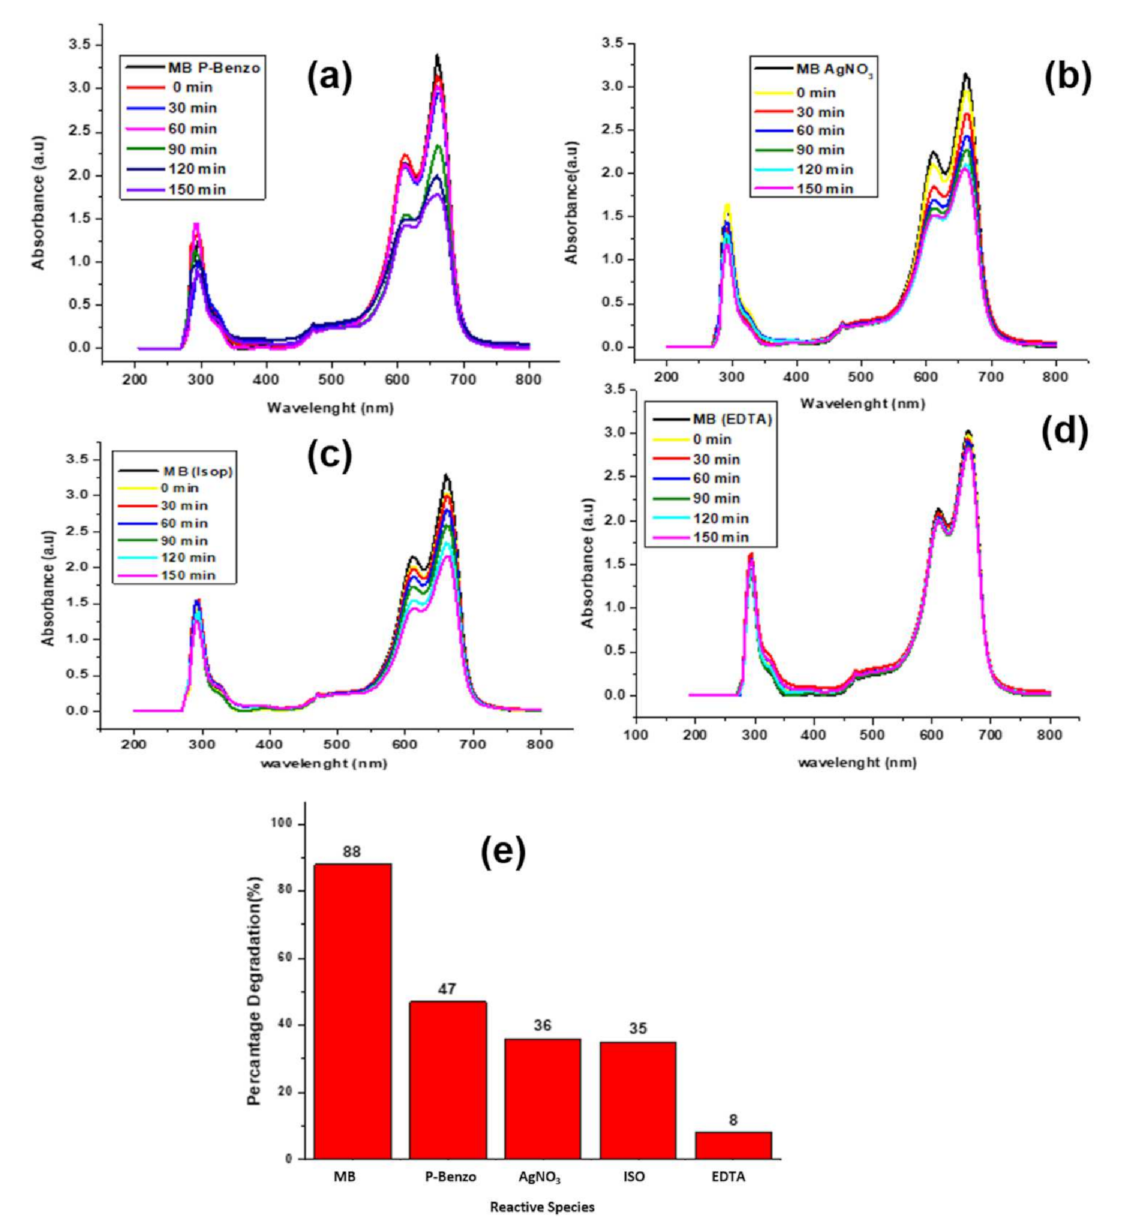
Figure 7. Quenching of active species using ( a ) p-benzo, ( b ) silver nitrate, ( c ) isopropanol, ( d ) EDTA and ( e ) percentage degradation in the presence of reactive